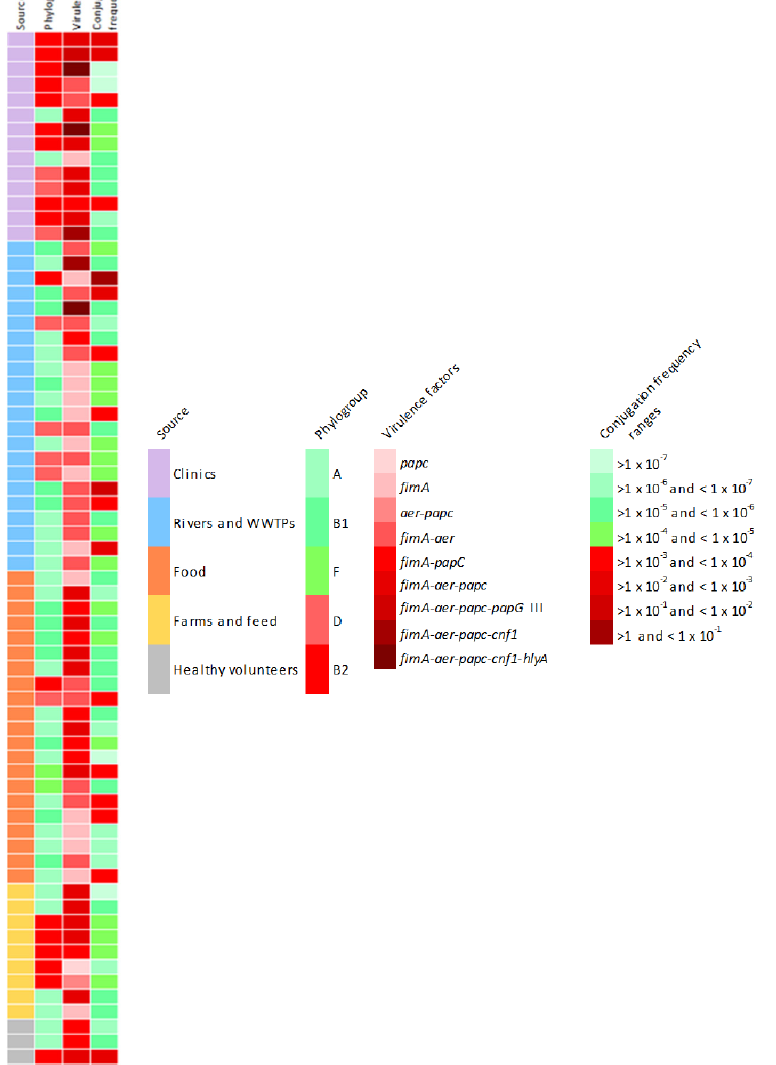
Figure 5. Phenotypic and genotypic characteristics of the 70 isolates tested in the conjugation assays. Red coloured boxes indicate the riskiest condition, according to the legend.